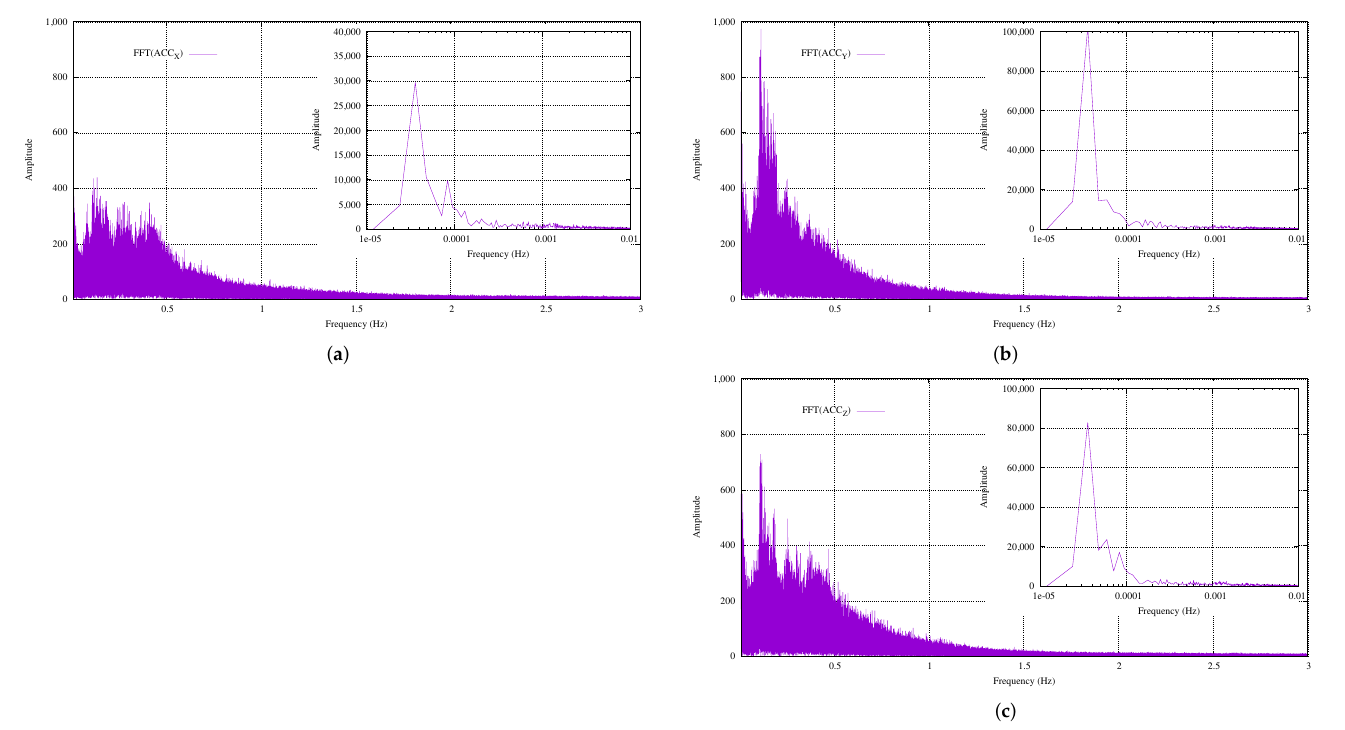
Figure 11. The frequency representations of the acquired data from the full day of